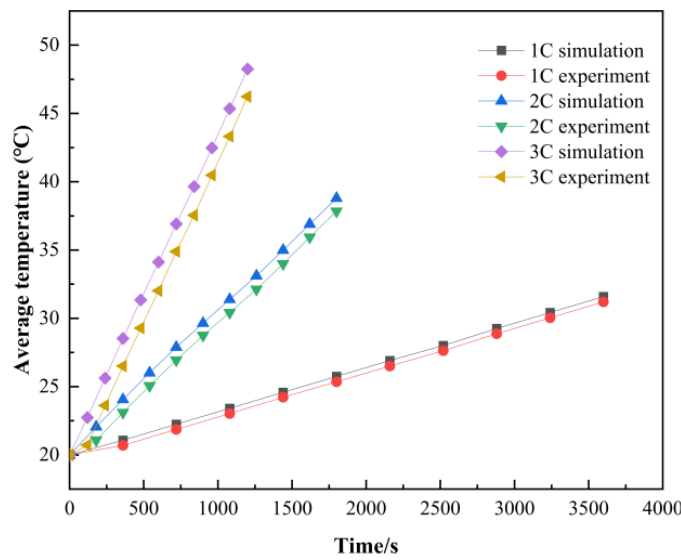
Figure 2. Battery model verification. Table 2. Heating generation power of 40 Ah battery at different discharge rates.